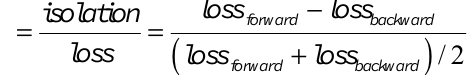
Ga As interfaces. 0.5 0.5